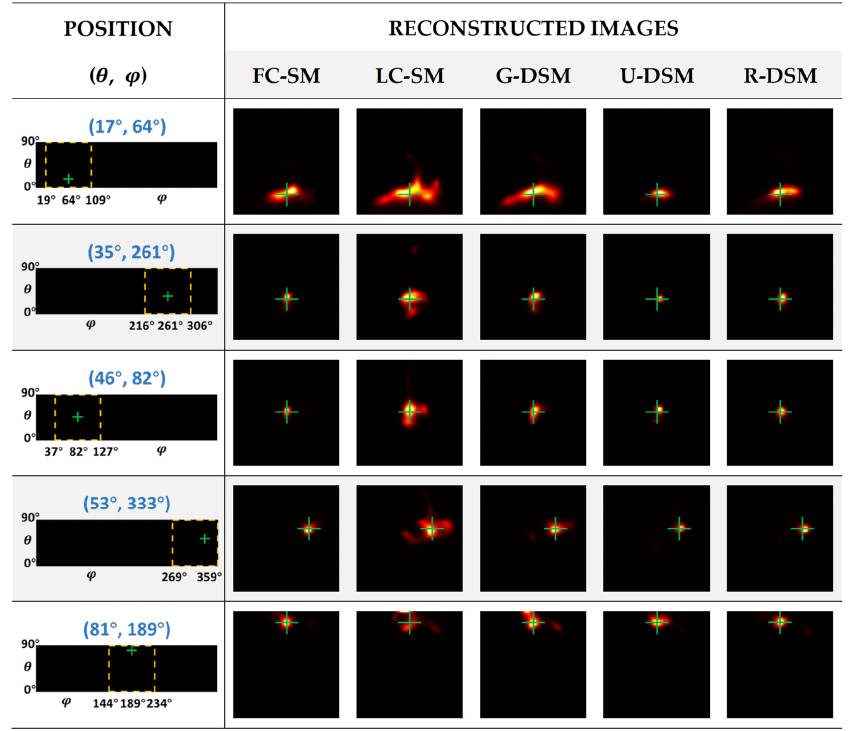
Figure 18. Reconstructed images of different SMs at representative positions for 99m Tc source in inter-device evaluation.